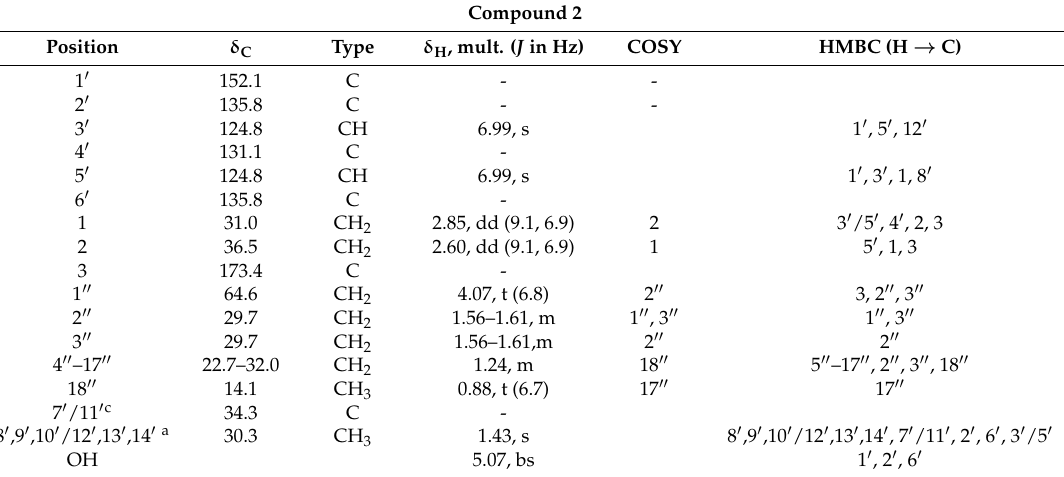
Table 2. 1D and 2D NMR data for Compound 2 in CDCl 3 (300 MHz for 1 H-NMR, and 75 MHz for 13